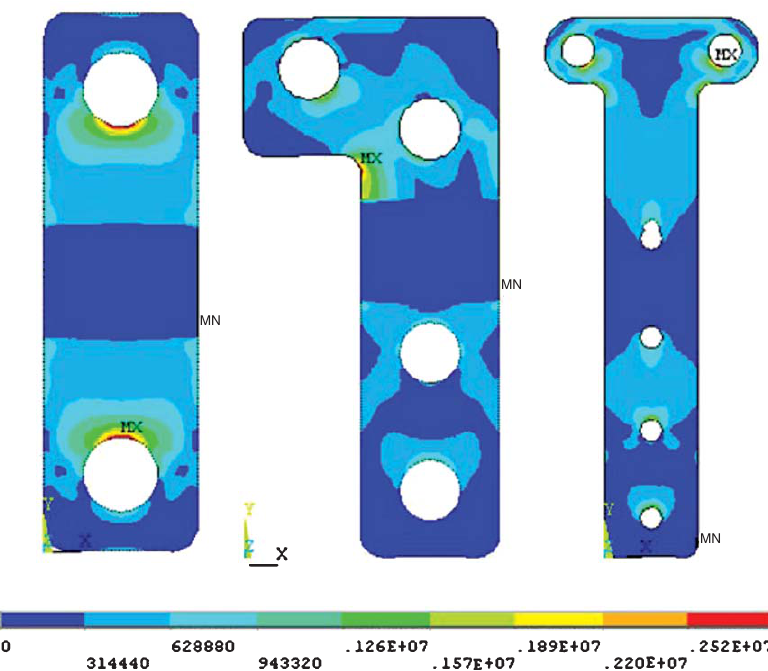
Fig. 8. Von Mises Stress Distribution on initial forms of the Plates (Deformation Scale=1 ∗ 1000).